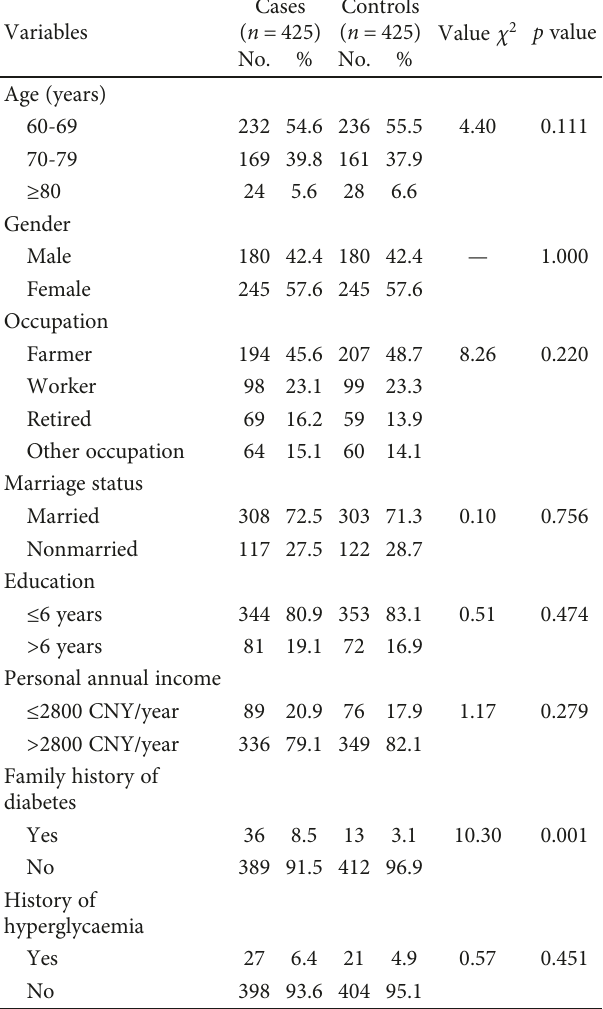
Table 1: Sociodemographic characteristics of the study subjects. Table 2: Lifestyle behaviour risk factors for prediabetes among the